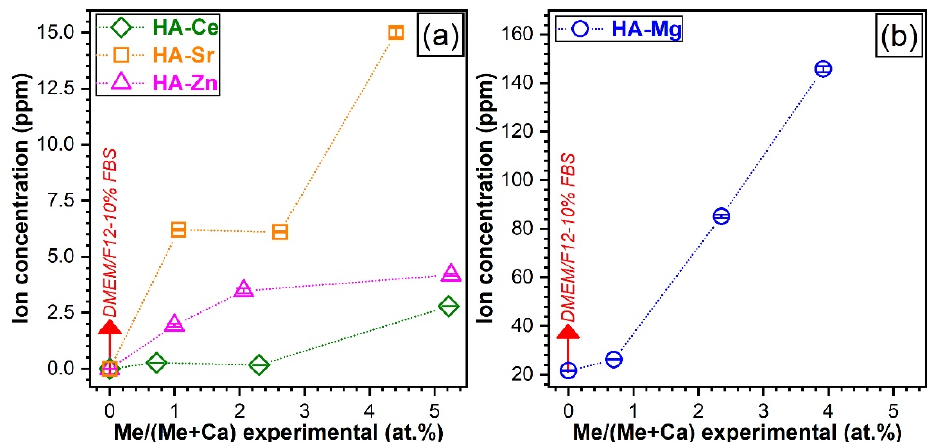
Figure 10. The concentrations of the ( a ) Ce, Sr, Zn and ( b ) Mg dopants leached after 48 h in the DMEM/F12-10%FBS solution by the SHA NPs, as determined by inductively coupled plasma mass spectrometry. The experimental data are presented as means ± standard deviations (n = 3).